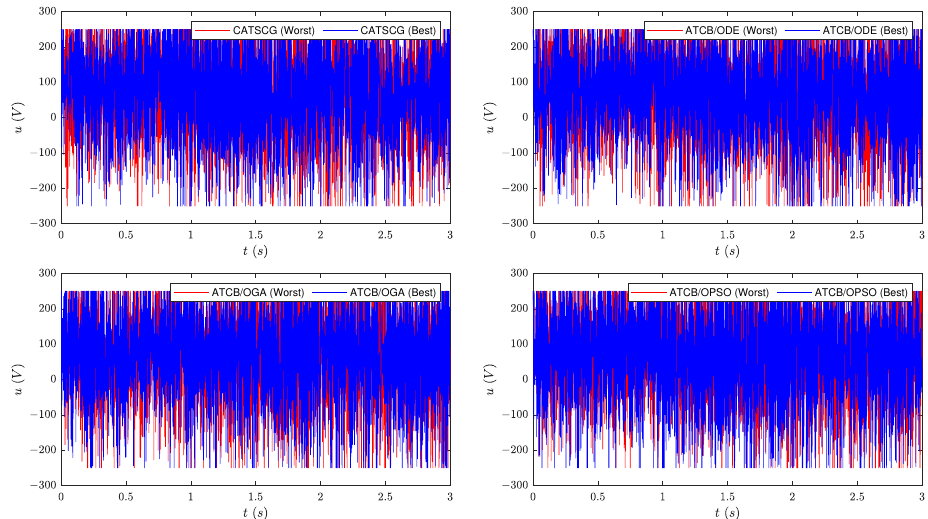
Figure 9. Control action for the best and worst runs of the adaptive controller tuning, consider- ing